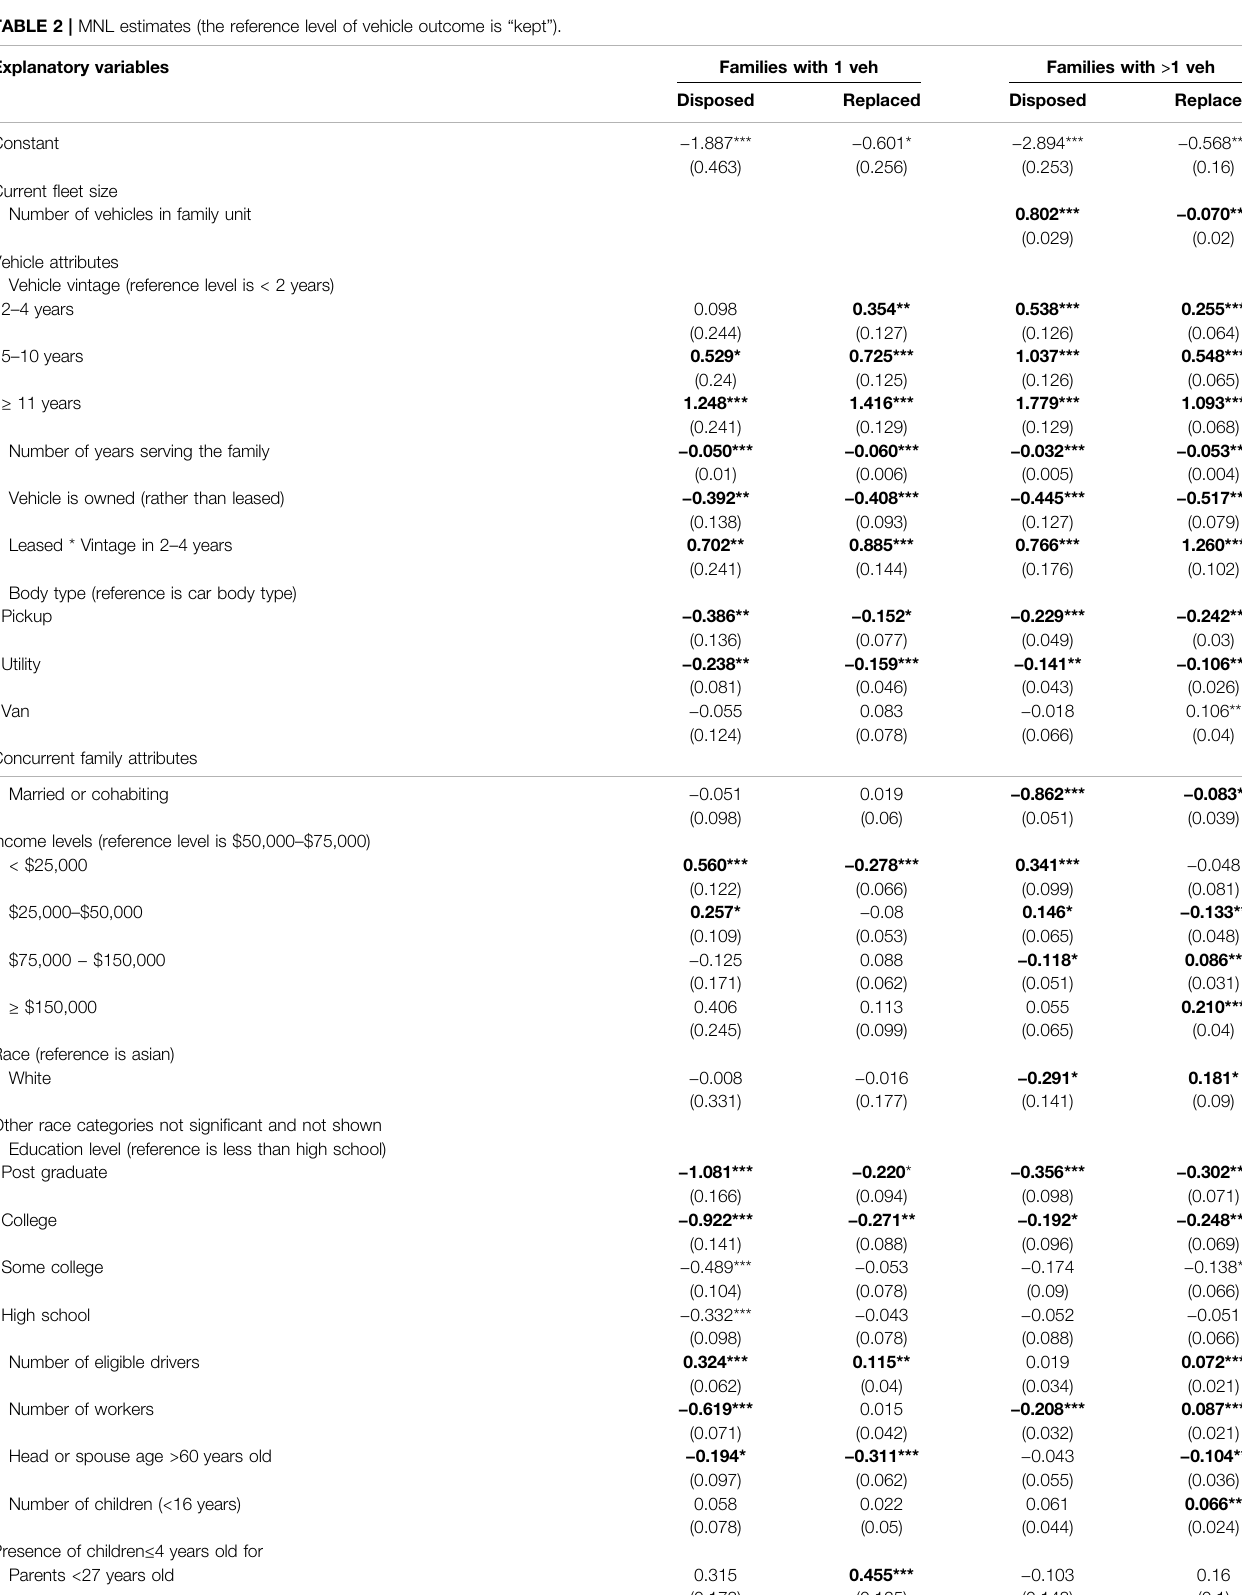
TABLE 2 | MNL estimates (the reference level of vehicle outcome is “ kept ”